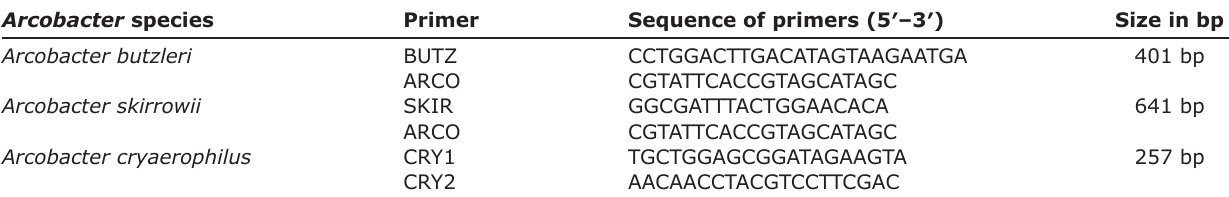
Table-1: Primers sequences used in the multiplex PCR assay [14]. Arcobacter species